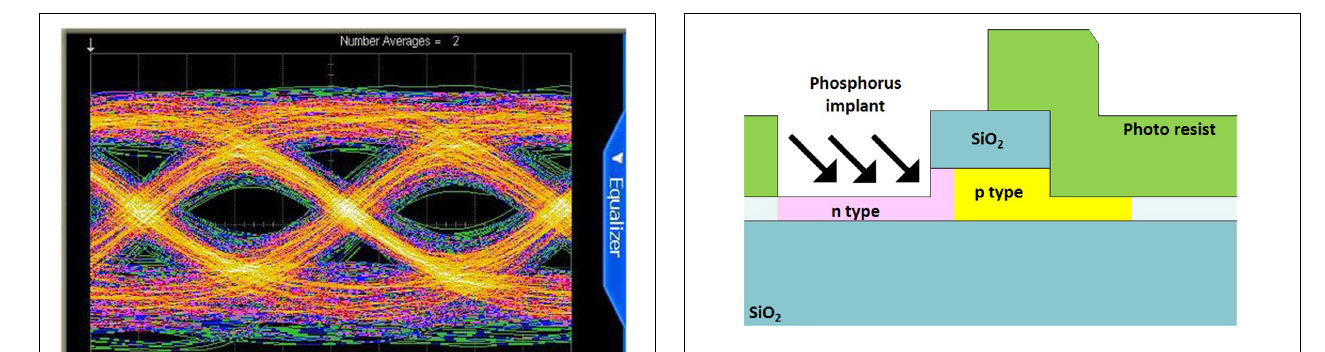
FIGURE 7 | Adjusted self-aligned process to allow doping within the waveguide